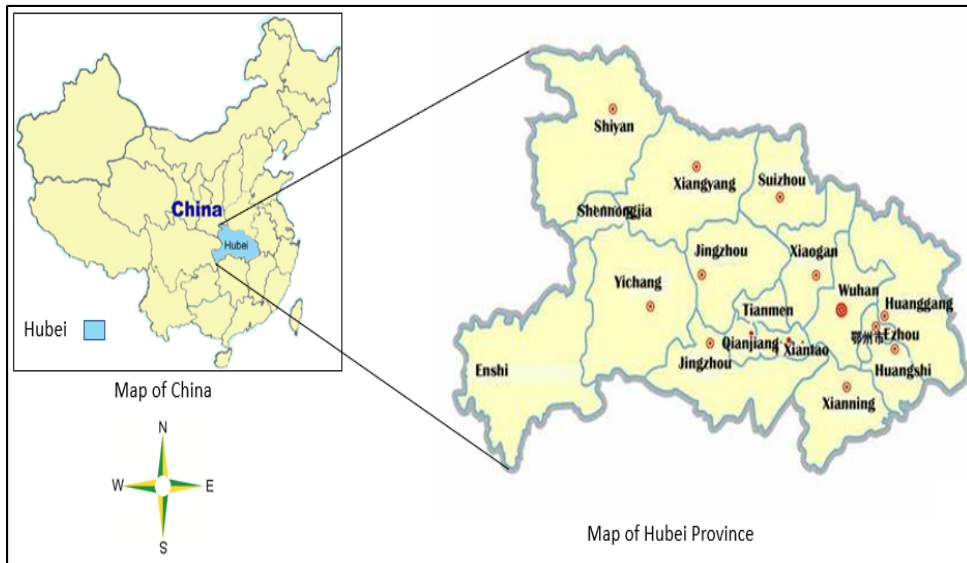
Figure 1. Map of the study area.